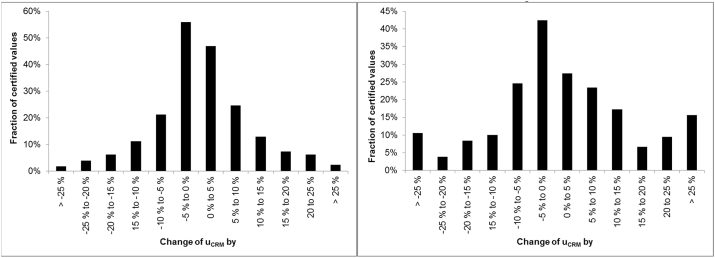
Effect on uCRM of a change of ubb by 30% (left) and 50% (right). Only ubb and uchar were considered for the estimation of uCRM for this analysis.